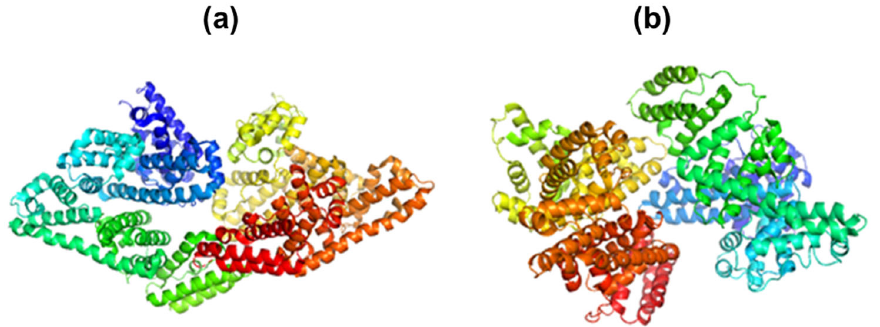
Figure 2. Crystallographic structures from protein data bank (PDB) of: ( a ) BSA molecule obtained through X ‐ Ray diffraction (PDB ID: 3V03); ( b ) HSA molecule obtained through X ‐ ray diffraction (PDB ID: 1AO6)). Each albumin domain is marked with a different color. The albumin structures have three domains (red, green, and blue) which are divided into two subdomains (light red, light green, and light blue, respectively).